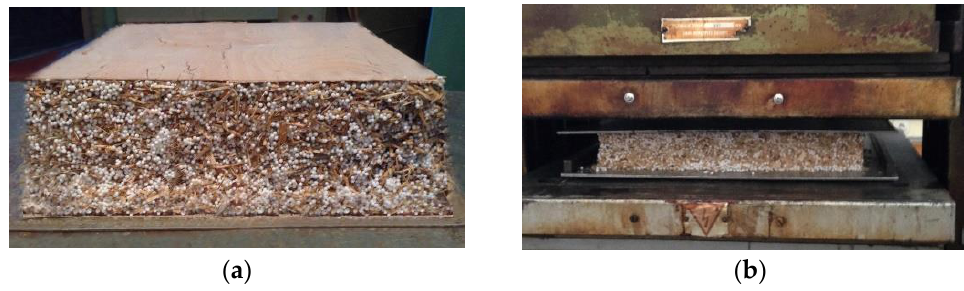
Figure 3. Pre-pressed mat ( a ) and the board pressing in the hot press ( b ).